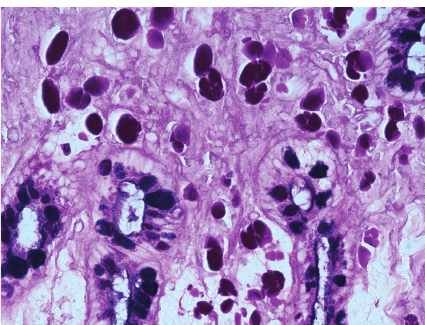
Figure 1: Upper endoscopy (esophagogastroduodenoscopy): a resi- dual 1–1.5cm band of salmon-pink Barrett mucosa separated from the gastroesophageal junction by endoscopically unremarkable squamous mucosa.